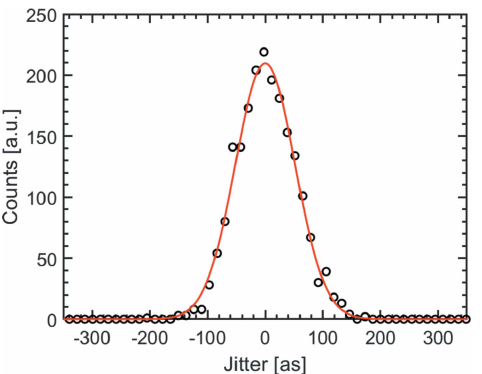
Figure 9 Jitter histogram of the SDU derived from interference measurements with visible light at 633 nm. AGaussian profile with a width t j = 121 (cid:4) 2 as (FWHM) has been fitted to the data. 2000 data points were taken with a sample period of 80 Hz, i.e. over a measurement time of 25 s.